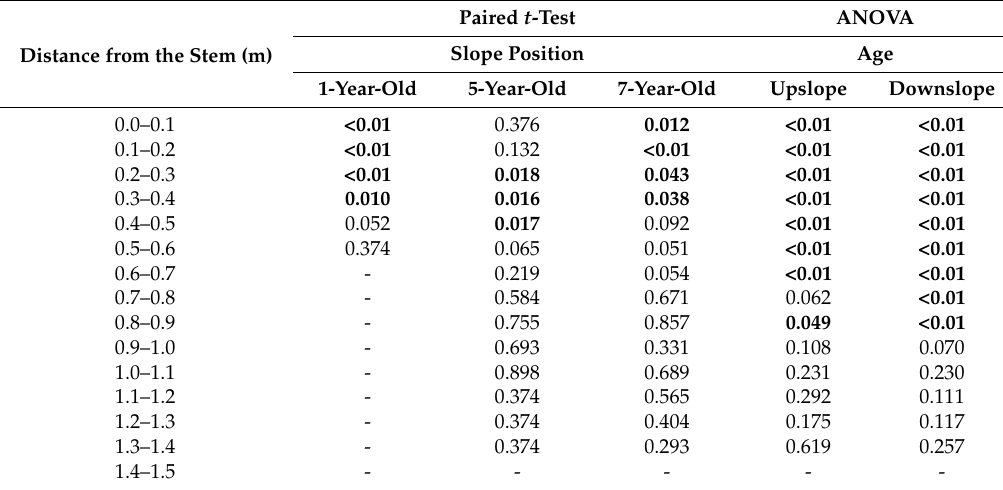
Table 9. Results of paired t -test and ANOVA for evaluating the effects of slope position and age on the root biomass across different distances from the stem. Paired t -Test ANOVA Slope Distance from the Stem (m)